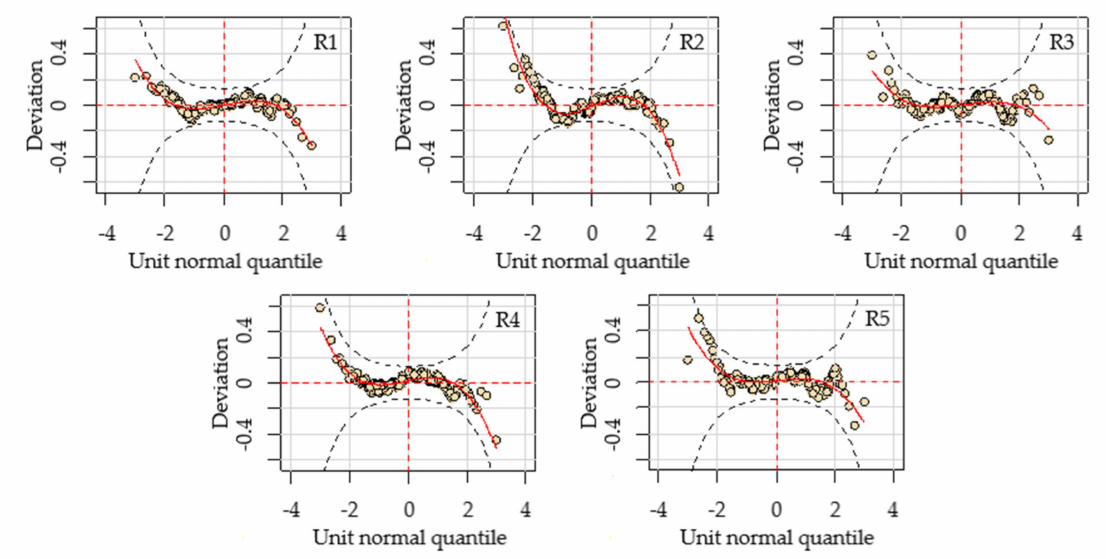
Figure 5. Residual diagnosis of the GAMLSS model characteristic of each homogeneous region in scenario S1, by structural worm-plot analysis.